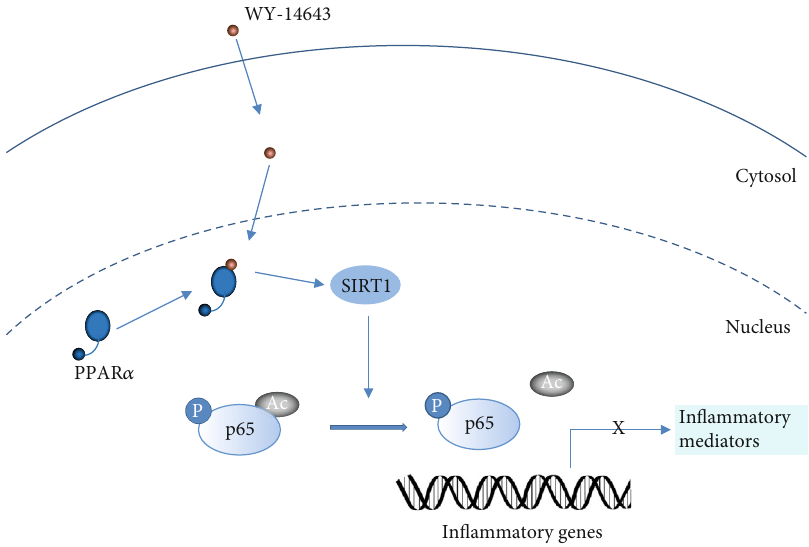
Figure 5: The PPAR α /SIRT1/NF- κ B pathway in the in fl ammation in